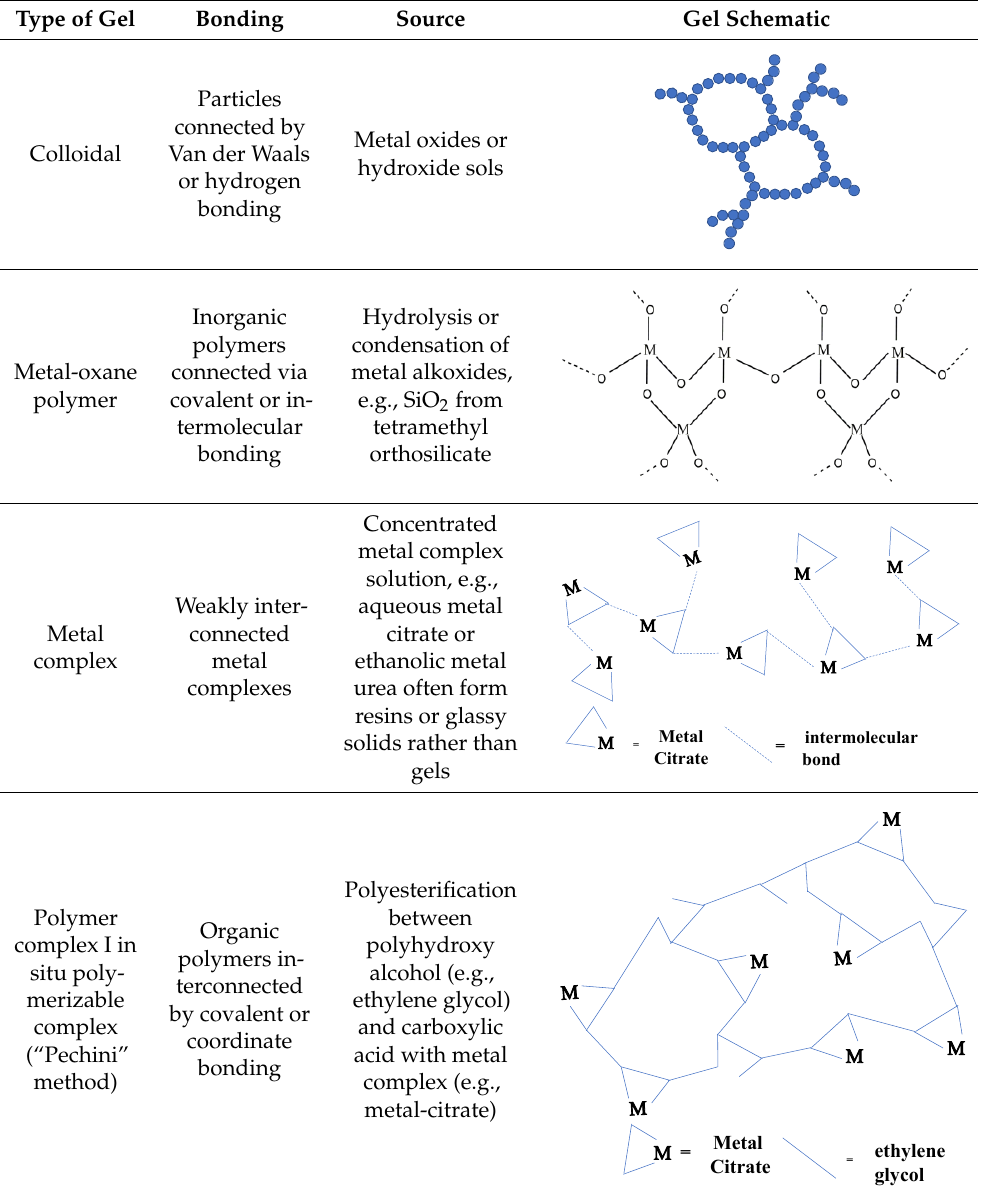
Table 1. Classification of five different types of “gels” essential to a material’s sol-gel synthesis [35].